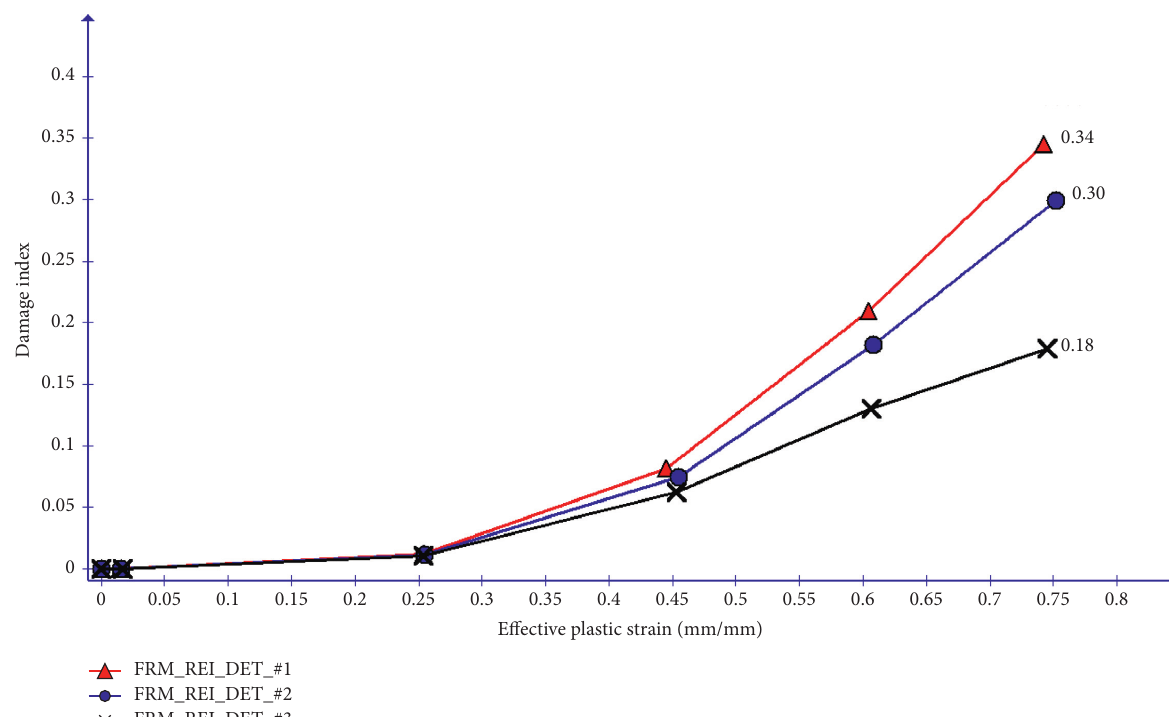
Figure 21: Column damage index vs. effective plastic strain plot for 91kg TNT explosive located at 1 st story ground floor slab.